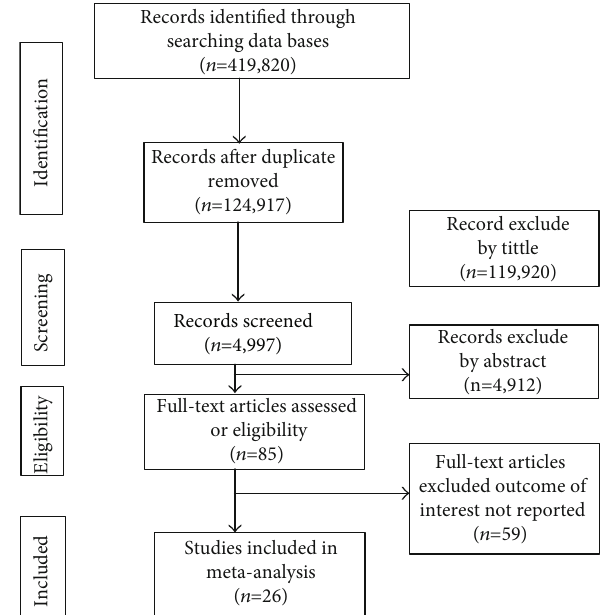
Figure 1: PRISMA fl ow diagram of study